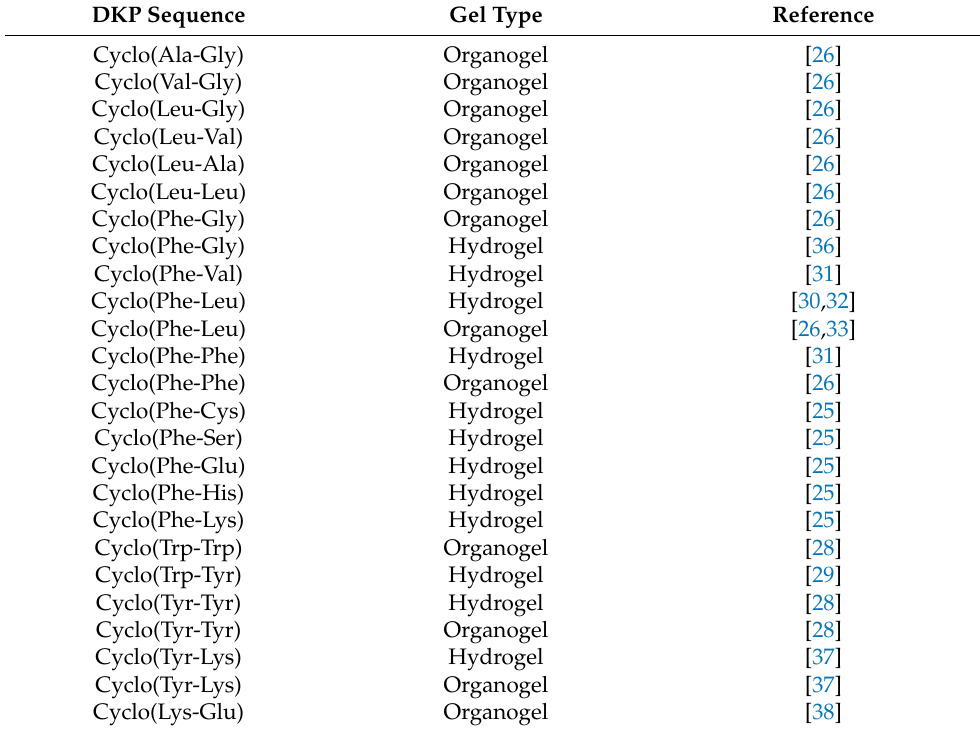
Table 1. Gelling DKPs obtained from unprotected dipeptides. Reproduced from [21]. DKP Sequence Gel